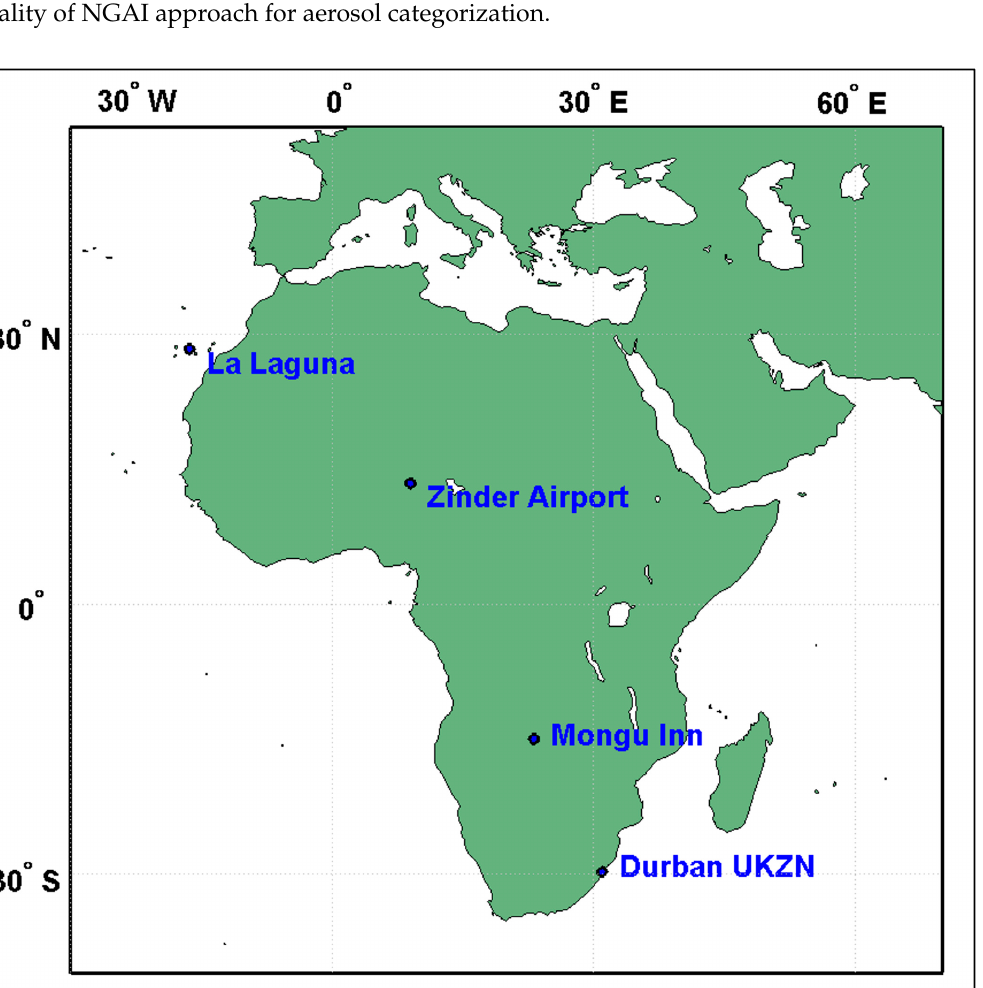
Figure A2. The distribution of the four ground-based measurements of AERONET sites include La Laguna (28.48 ◦ N, 16.32 ◦ W), Zinder Airport (13.78 ◦ N, 8.99 ◦ E), Mongu Inn (15.27 ◦ S, 23.13 ◦ E) and Durban UKZN (29.82 ◦ S, 30.94 ◦ E), from North Africa to South Africa.